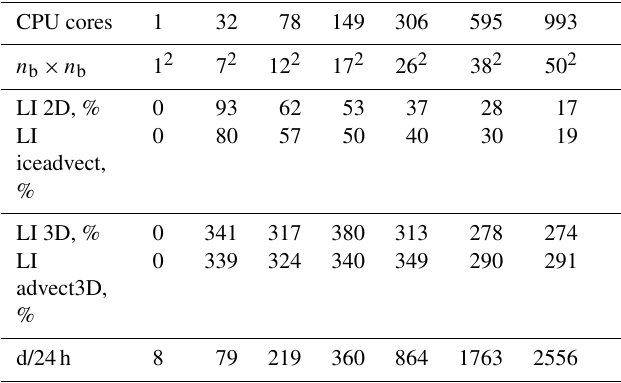
Table 1. The model with the 1block partition: n b × n b is the grid of blocks, and LI 2D and LI 3D are load imbalances (Eq. 3) for weights w 2d and w 3d , respectively. “LI iceadvect” and “LI ad- vect3D” are LIs computed based on the runtime of corresponding functions without exchanges, and d/24h is the number of computed days for 1 astronomical day. CPU cores